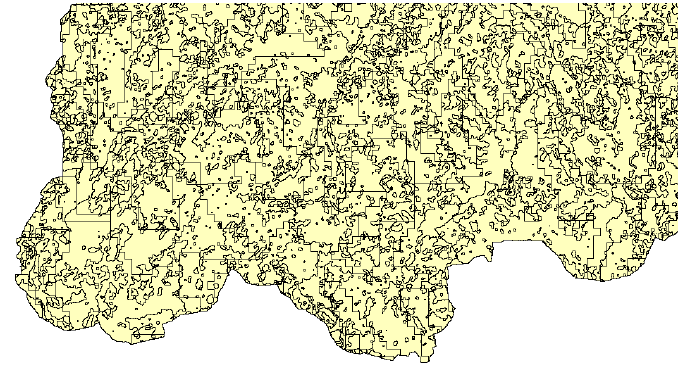
Figure 3. A part of the hydrological response unit (HRU) division results of Jiulong River basin in 2010.